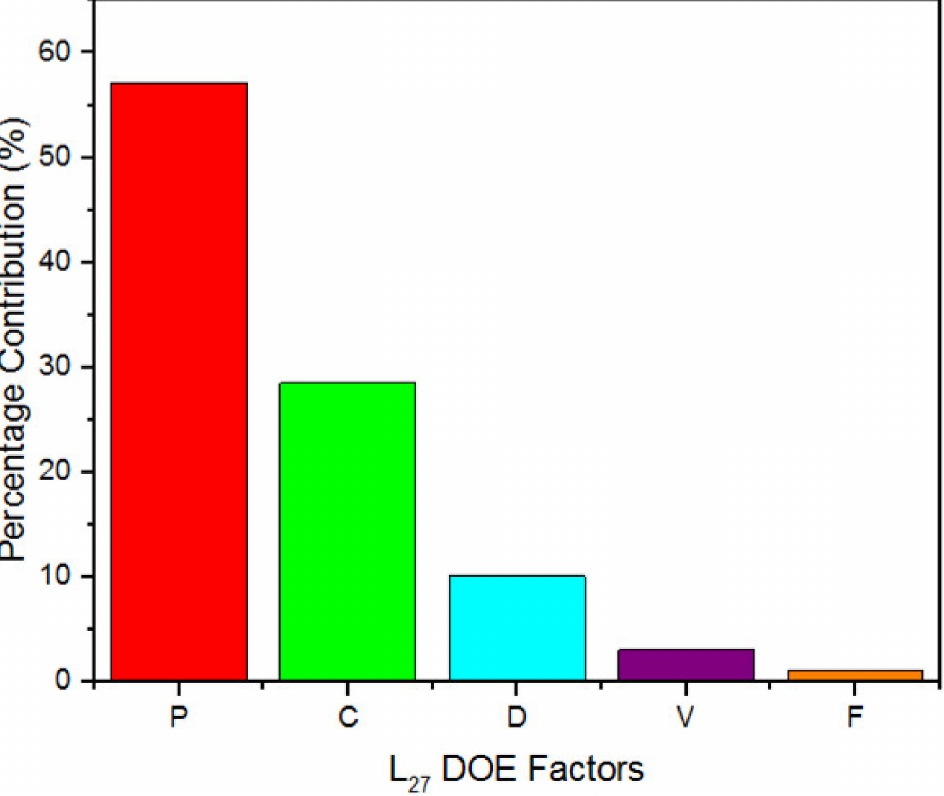
Figure 6. ANOVA diagram for the determination of significant factors influencing electrospun polymer nanofiber